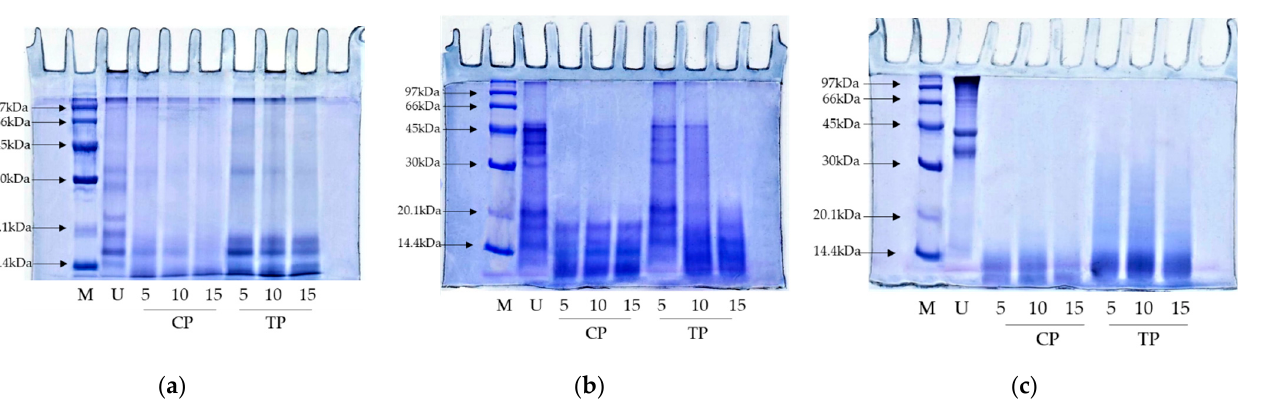
Figure 6. Protein pattern of ( a ) whey protein isolate; ( b ) kidney bean protein isolate; ( c ) threadfin bream fish mincewithout digestion (U) and after being digested using commercial pepsin (CP) and skipjack tuna pepsin (TP) at different levels. Number designates the level of enzyme (units/g protein). Low molecular weight marker (M).